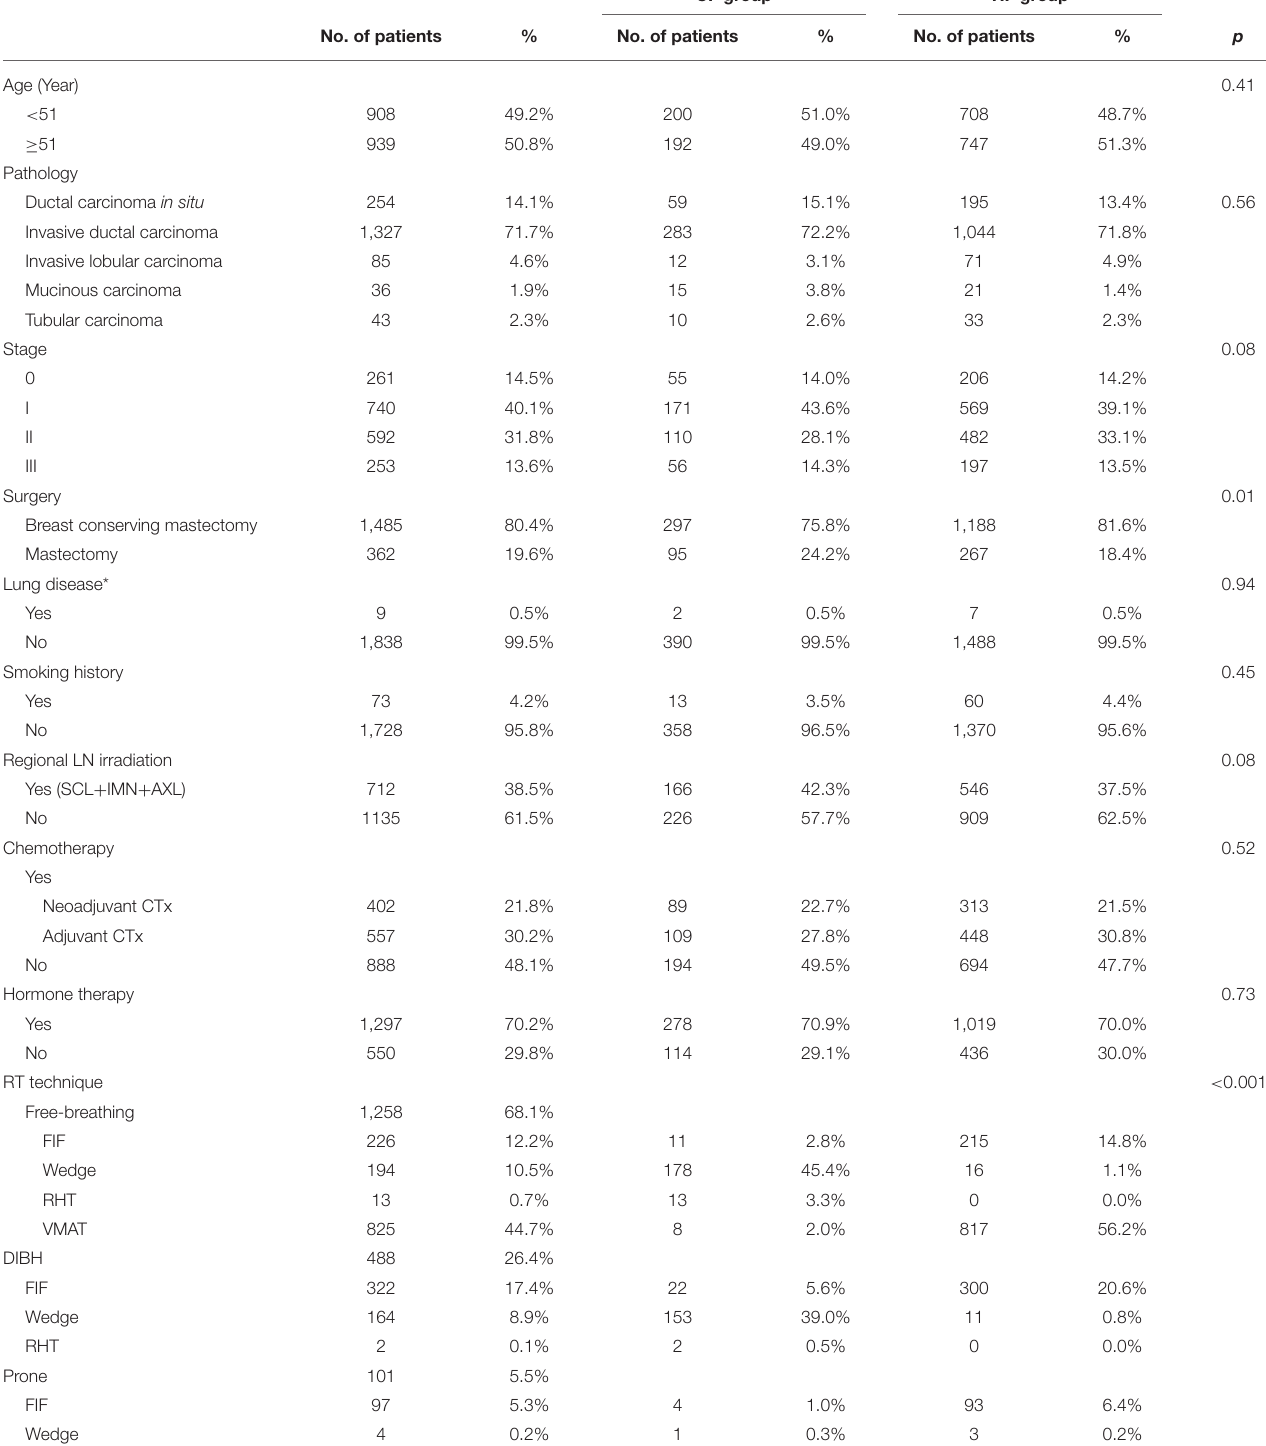
TABLE 1 | Patient characteristics and treatment